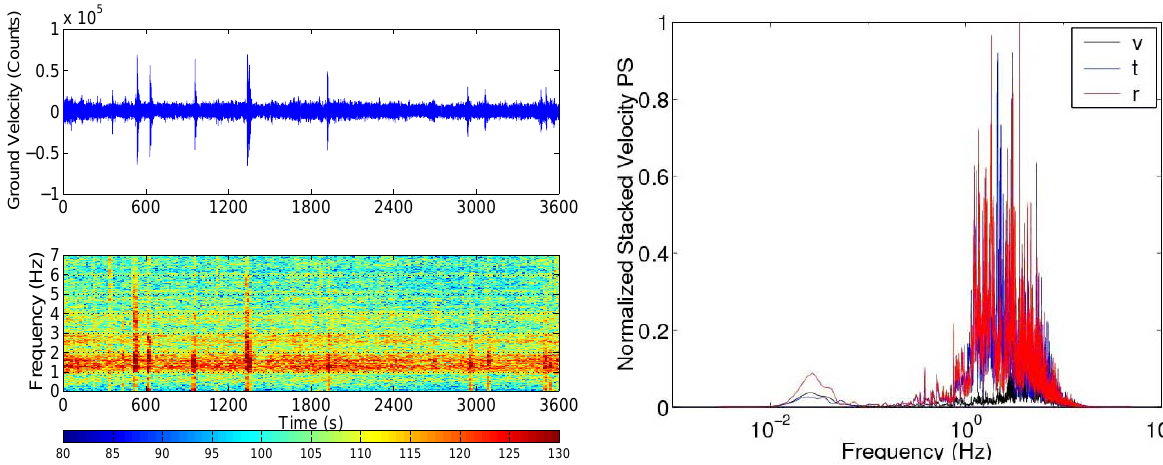
Fig. 2. Left panel: an example of seismic recordings acquired at Stromboli in 1997. Explosion-quakes are visible superposed to the background volcanic tremor (upper panel) and in the related spectrogram (lower panel). The spectrogram was calculated using a Fast Fourier Transform (FFT) with a sliding Hanning windowing (from De Lauro et al., 2008). Right panel: the normalized stacked power spectrum of the seismic series shows that the energy is mainly concentrated into three distinct frequency bands (different colors regard the radial ( r ), transverse ( t ) and vertical ( v ) directions of motion).